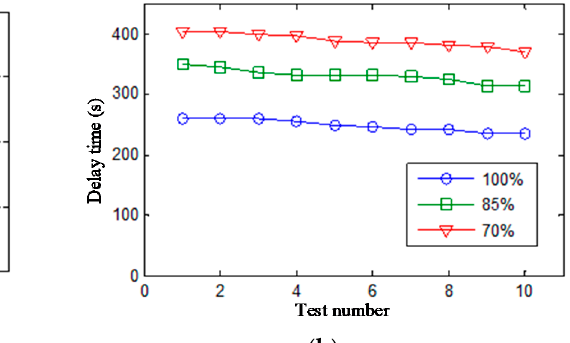
Figure 15. Ten 10 times test results vary with three connection areas: ( a ) peak temperature increment; ( b ) delay time to peak temperature.